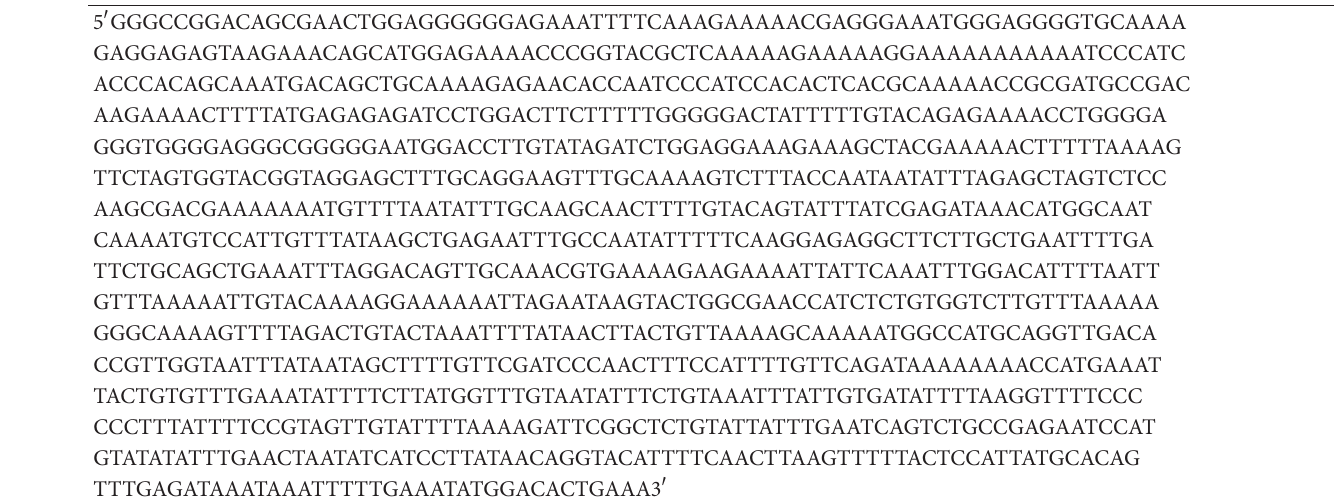
Table 4: SOX2 3 󸀠 untranslated region (3 󸀠 UTR).